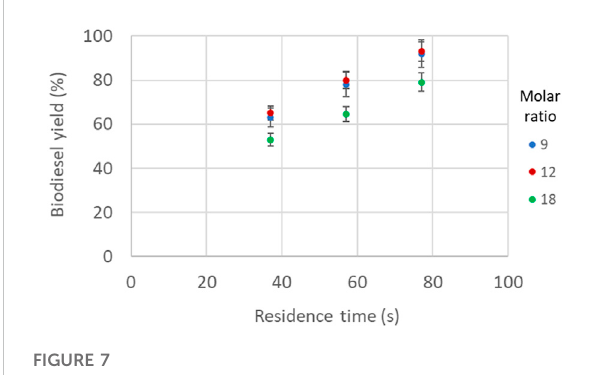
FIGURE 7 Biodiesel yield as a function of methanol-to-oil molar ratio and residence time (constant temperature 60 ° C, constant catalyst concentration 1.4%